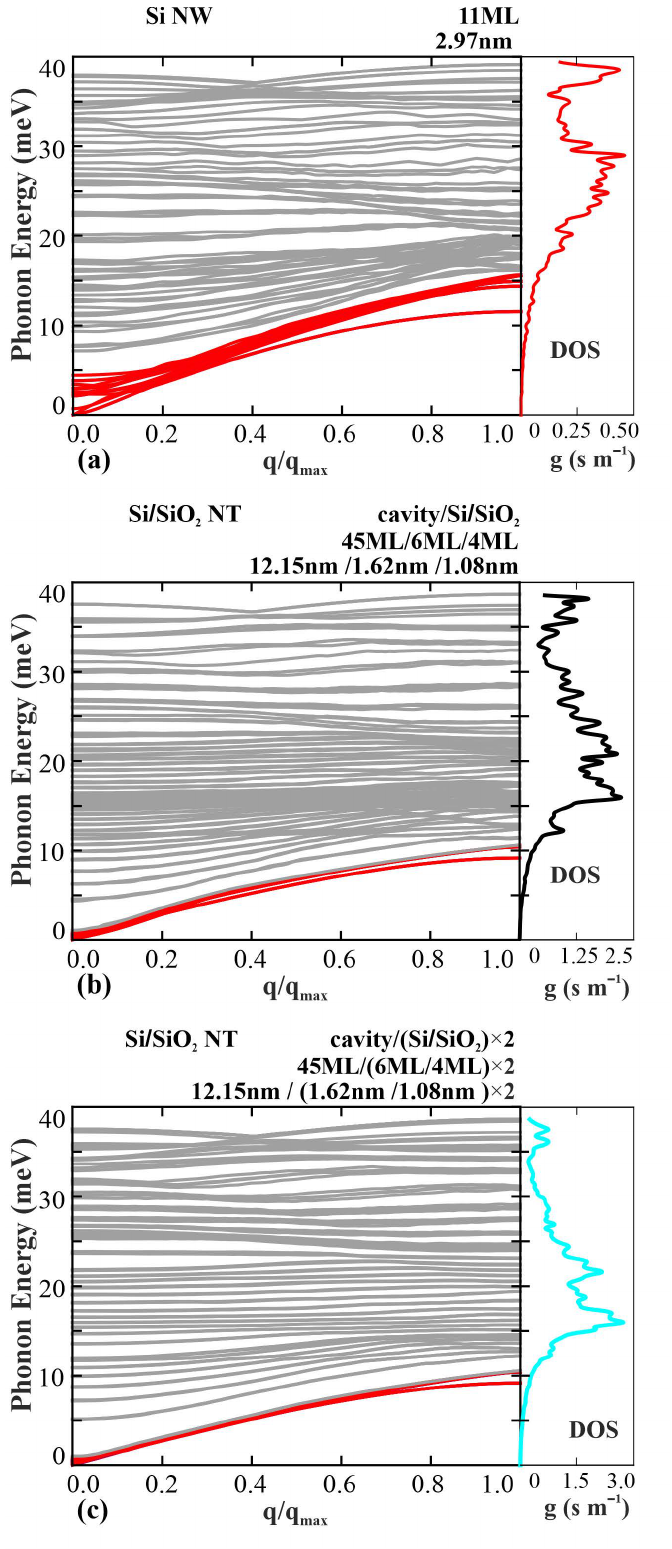
Figure 2. Phonon dispersions and phonon density of states in the Si NW with the cross section 11 ML × 11 ML (panel ( a )); in the Si/SiO × 45 ML and 2 NTs (nanotubes) with the cavity cross section 45 ML a single Si/SiO 2 bilayer shell (panel ( b )) and two Si/SiO 2 bilayer shells (panel ( c )). The thicknesses of silicon and silica layers in the Si/SiO 2 bilayer are 6 ML and 4 ML,